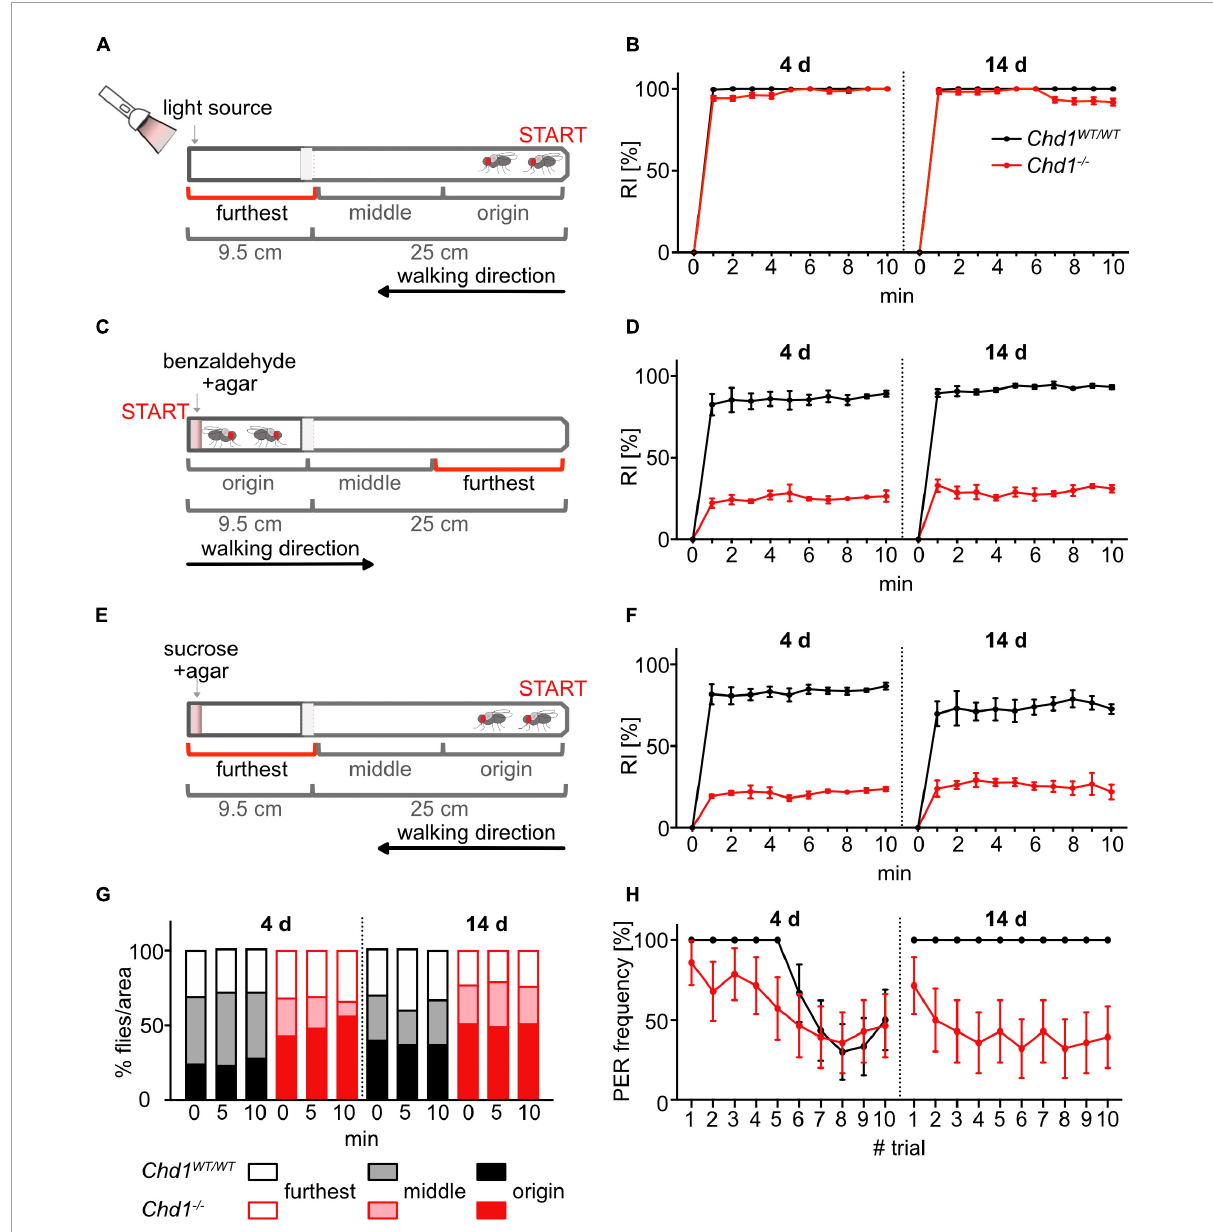
FIGURE2 Absence of CHD1 impairs olfactory and gustatory perception. (A) Experimental set-up of the assay used to assess positive phototaxis. (B) Positive phototaxis response indices (RI) of 4 and 14 days old Chd1 WT / WT and Chd1 − / − flies. Mean ± SEM of six replicates (20 flies per group) are shown. (C,E) Experimental set-up to test olfactory behavior in response to the repellent odorant benzaldehyde (C) and gustatory response behavior to sucrose (E) . (D,F) Repulsion (D) and attraction (F) response indices of 4 and 14 days old Chd1 WT / WT and Chd1 − / − flies. Mean ± SEM of six technical replicates (20 flies per group) and three independent experiments are shown. 3-way ANOVA of (B,D,F) : genotype main effect: (B) F (1,8) = 124.66, p < 0.0001; (D) F (1,88) = 3809, p < 0.0001; (F) F (1,88) = 1680, p < 0.0001; age main effect: (B) F (1,8) = 3.267, ns; (D) F (1,88) = 28.41, p < 0.0001; (F) F (1,88) = 3.500, p = 0.0647; trial main effect: (B) F (10,80) = 5872, p < 0.0001; (D) F (10,88) = 135.8, p < 0.0001, (F) F (10,88) = 58.59, p < 0.0001; interaction (age × genotype) effect: (B) F (1,8) = 3.474, p = 0.0993; (D) F (1,88) = 1.289, p = 0.2594; (F) F (1,88) = 28.10, p < 0.0001; interaction (trial × age × genotype) effect: (B) F (10,80) = 4.458, p < 0.0001; (D) F (10,88) = 0.3576, p = 0.9613; (F) F (10,88) = 0.34789, p = 0.8996, (G) Behavior of flies in the test set-up shown in panels C,E in the absence of any stimulus. Percentage of flies in the different sectors at 0, 5, and 10 min of the test. Mean ± SEM of 3 technical replicates (20 flies per group) and 3 independent experiments are shown. 2-way ANOVA of interaction (genotype × time lapse) effect: F (22,684) = 887713; genotype main effect: F (11,684) = 517.0; time lapse effect: F (2,684) = 2934590; age main effect: F (9,27) = 3.535, p = 0.0052; genotype main effect: F (3,27) = 28.22. (H) Proboscis extension response (PER) frequency in 10 sequential tastant offerings with ingestion permitted ( n = 30 per genotype and age). 2-way ANOVA of age main effect: F (9,27) = 3.535; genotype main effect: F (3,27) =